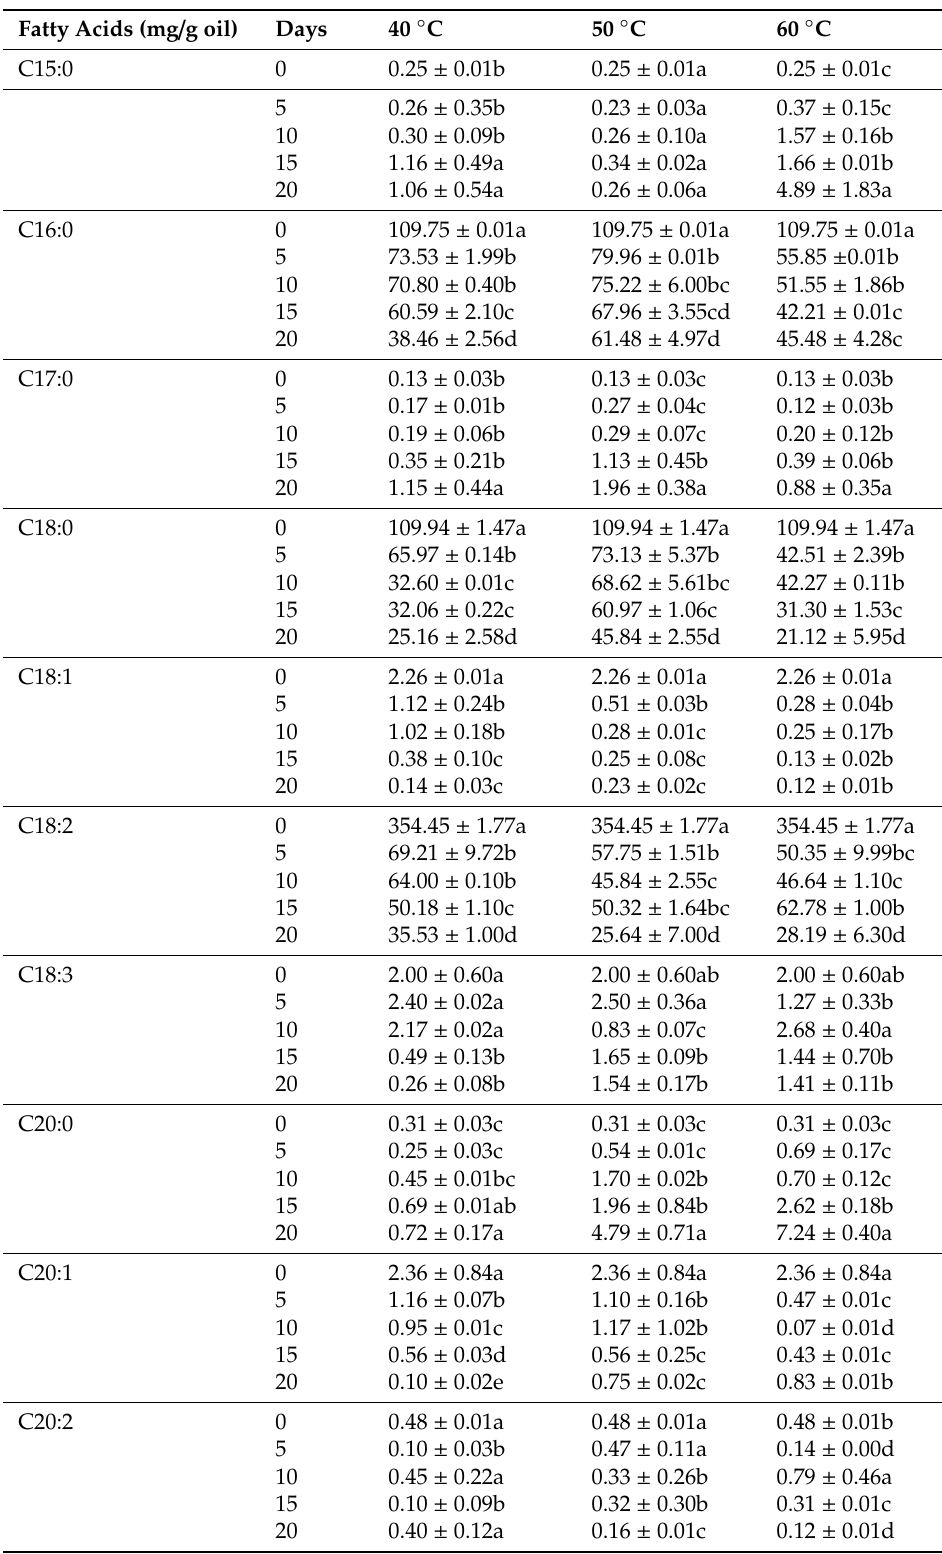
Table 1. Changes in fatty acid content of green co ff ee beans during accelerated storage at various